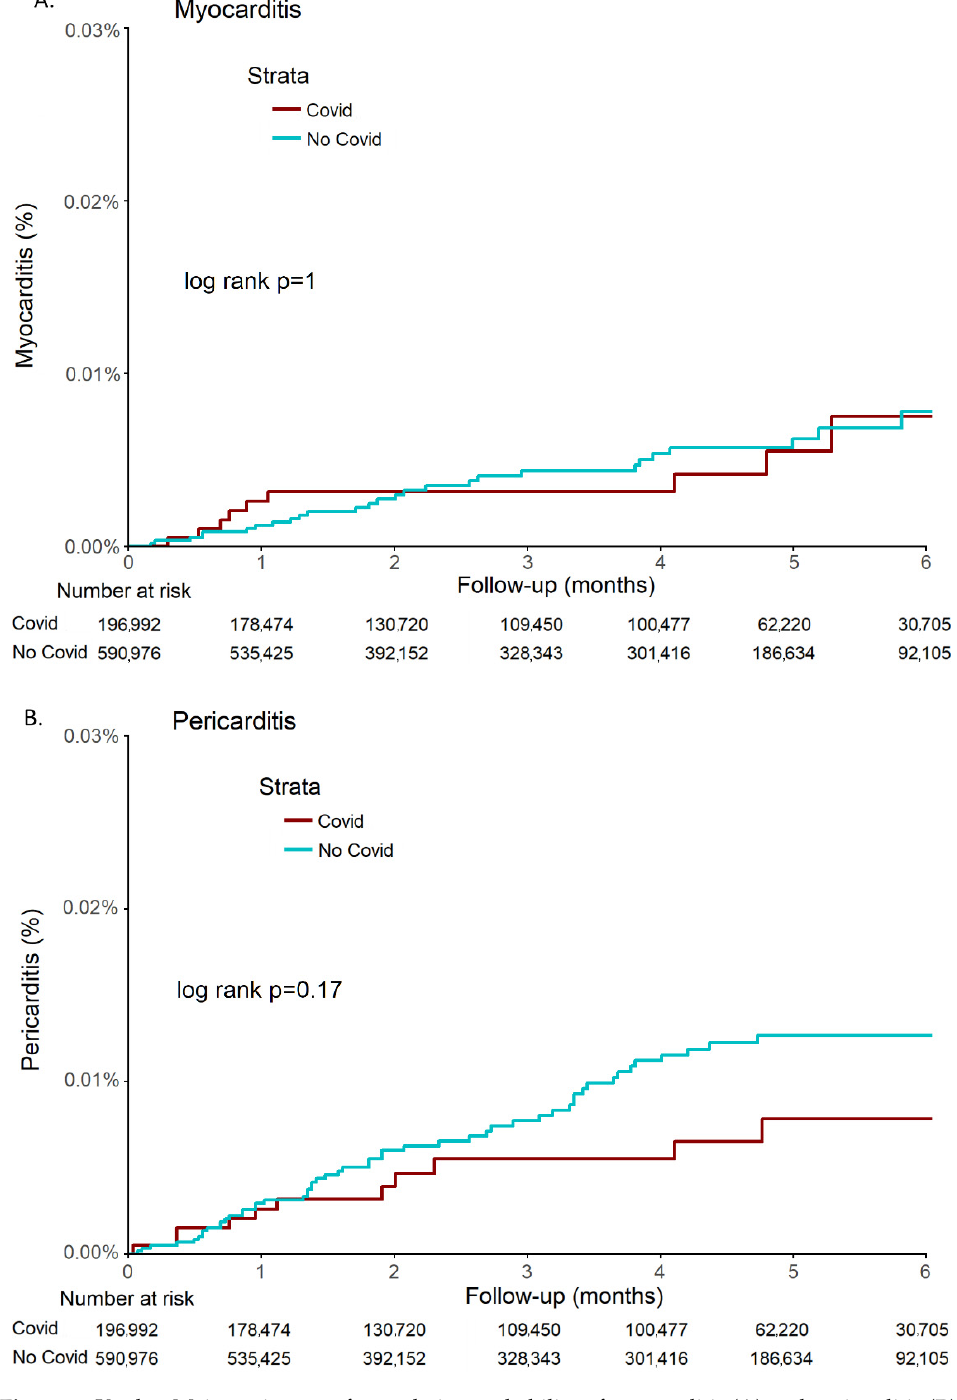
Figure 2. Kaplan-Meier estimates of cumulative probability of myocarditis ( A ) and pericarditis ( B ) in COVID-19 and control cohorts during 6 months.